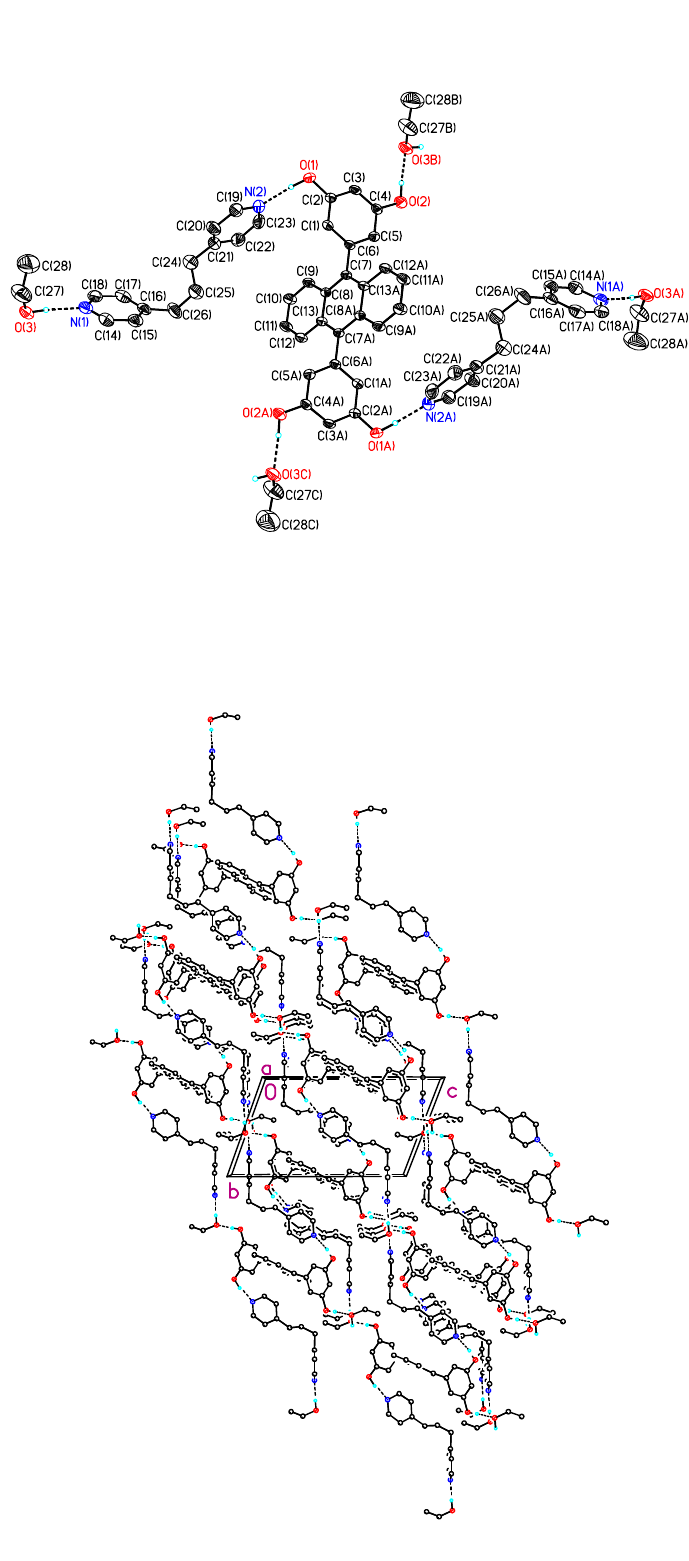
Figure 3 (a) The crystal structure of 3. Hydrogens were omitted for clarity. (b) The crystal-packing of 3 viewed down the a axis. Notice that 3 leads to a zigzag